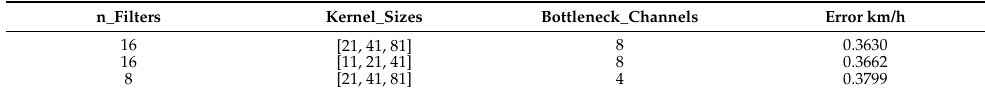
Table A3. Summary of the best hyper-parameters of the InceptionTime.